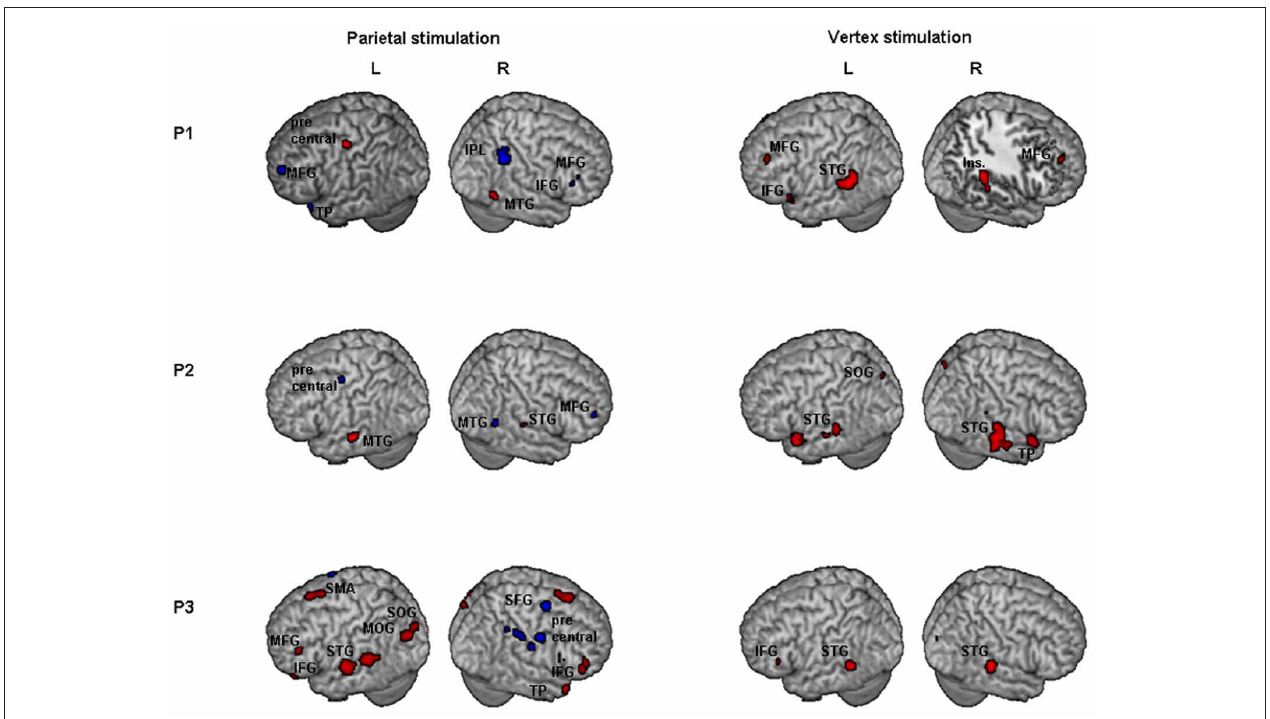
FIGURE 3 | Individual fMRI results. Neural effect of task execution with vs. without TMS for the parietal and vertex stimulation: Participant 1, P1; Participant 2, P2; Participant 3, P3. Blue and red indicate areas with a significantly ( P < 0 . 001 uncorrected; cluster level P < 0 . 05 corrected) reduced or increased neural activity, respectively. AG, Angular Gyrus; IFG,